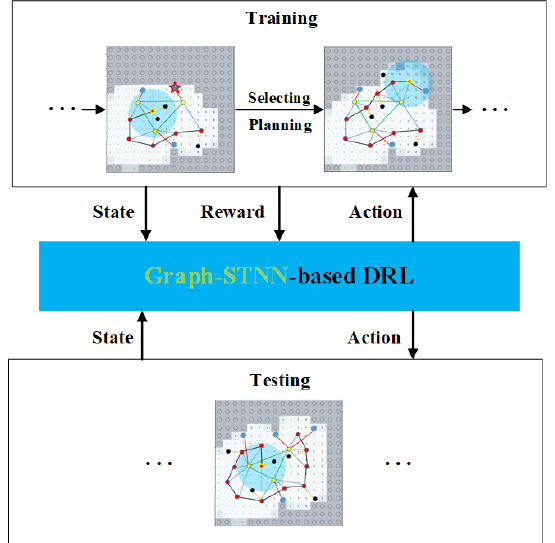
Figure 1. The framework of our approach. The grid environment is modeled as an exploration graph consisting of historical trajectories, frontier waypoints, landmarks, and obstacles shown in red, blue, yellow, and black. The red pentagram represents the currently selected target point, and the exploration graph represents the current state. In the training phase, the robot optimizes the network parameters to maximize the desired reward of the whole exploration progress. Then in the testing phase, our approach evaluates the frontier waypoints and selects the optimal one as the target